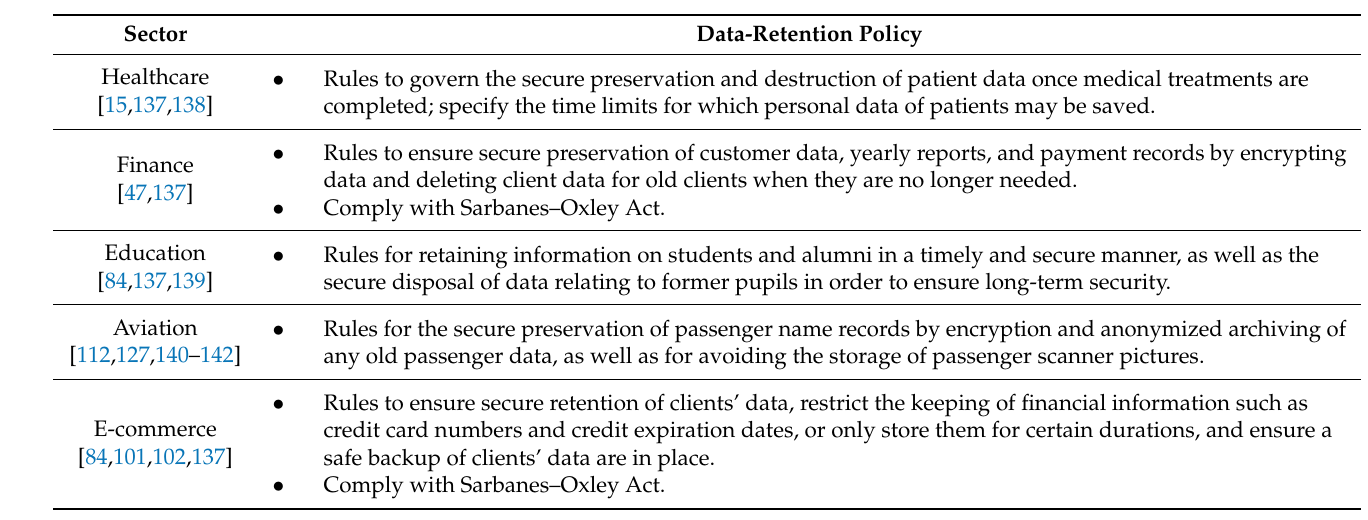
Table 10. Data-retention policy among different